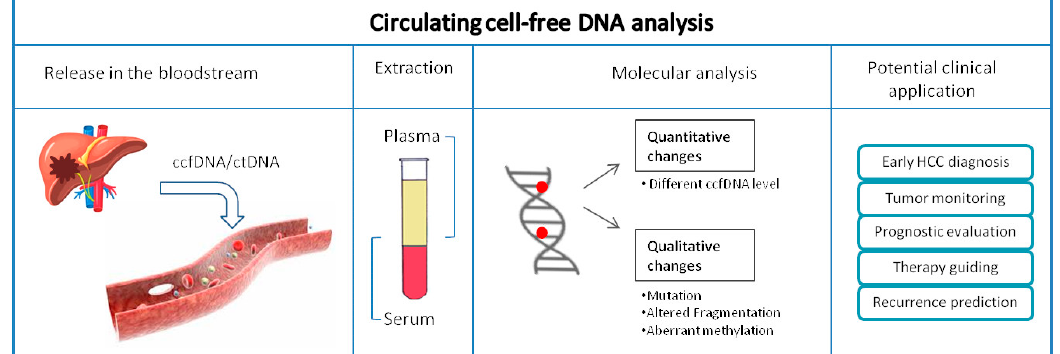
Figure 1. Schematic overview of circulating cell-free DNA analysis and its potential clinical application in hepatocellular carcinoma (HCC) setting. Circulating cell-free DNA (ccfDNA) can be released in the bloodstream from a variety of di ff erent cells under physiological and pathophysiological